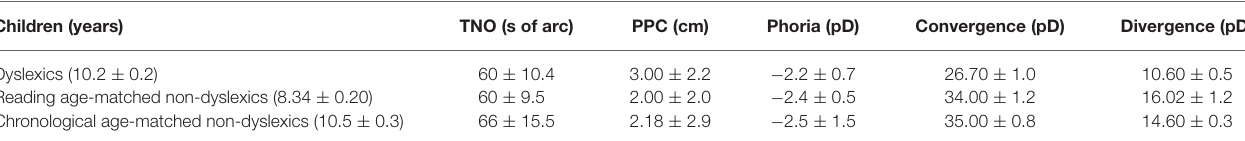
TABLE 2 | Clinical characteristics of children